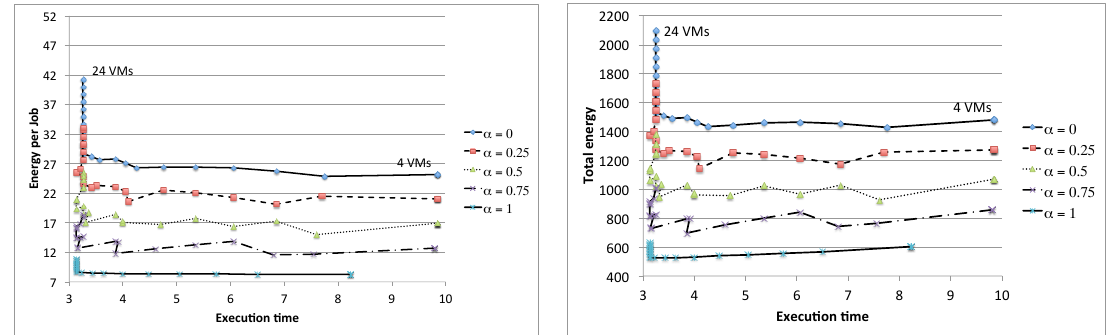
Figure 22. Heterogeneous environment: energy per job ( left ) and total energy ( right ) with synchronous